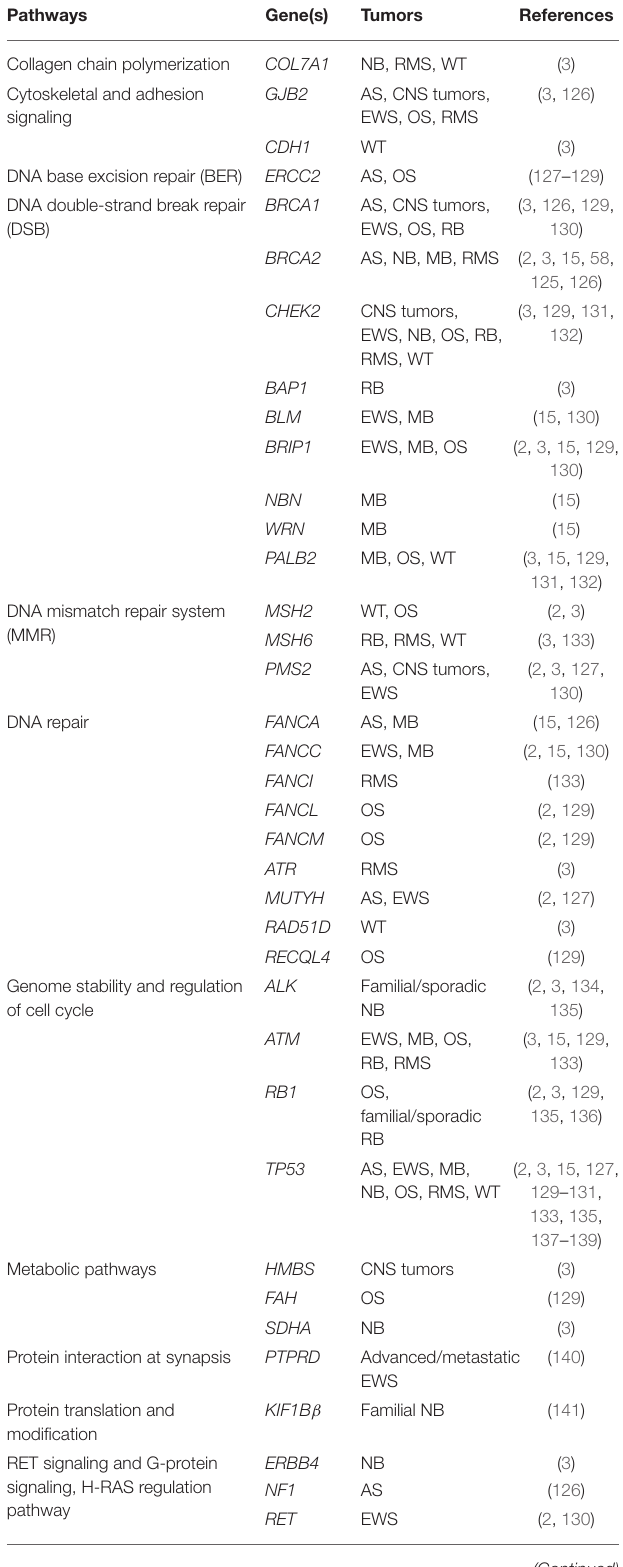
TABLE 1 | Rare, high-penetrance, and uncommon, moderate-penetrance variants in genes predisposing to pediatric tumors and main biological pathways.